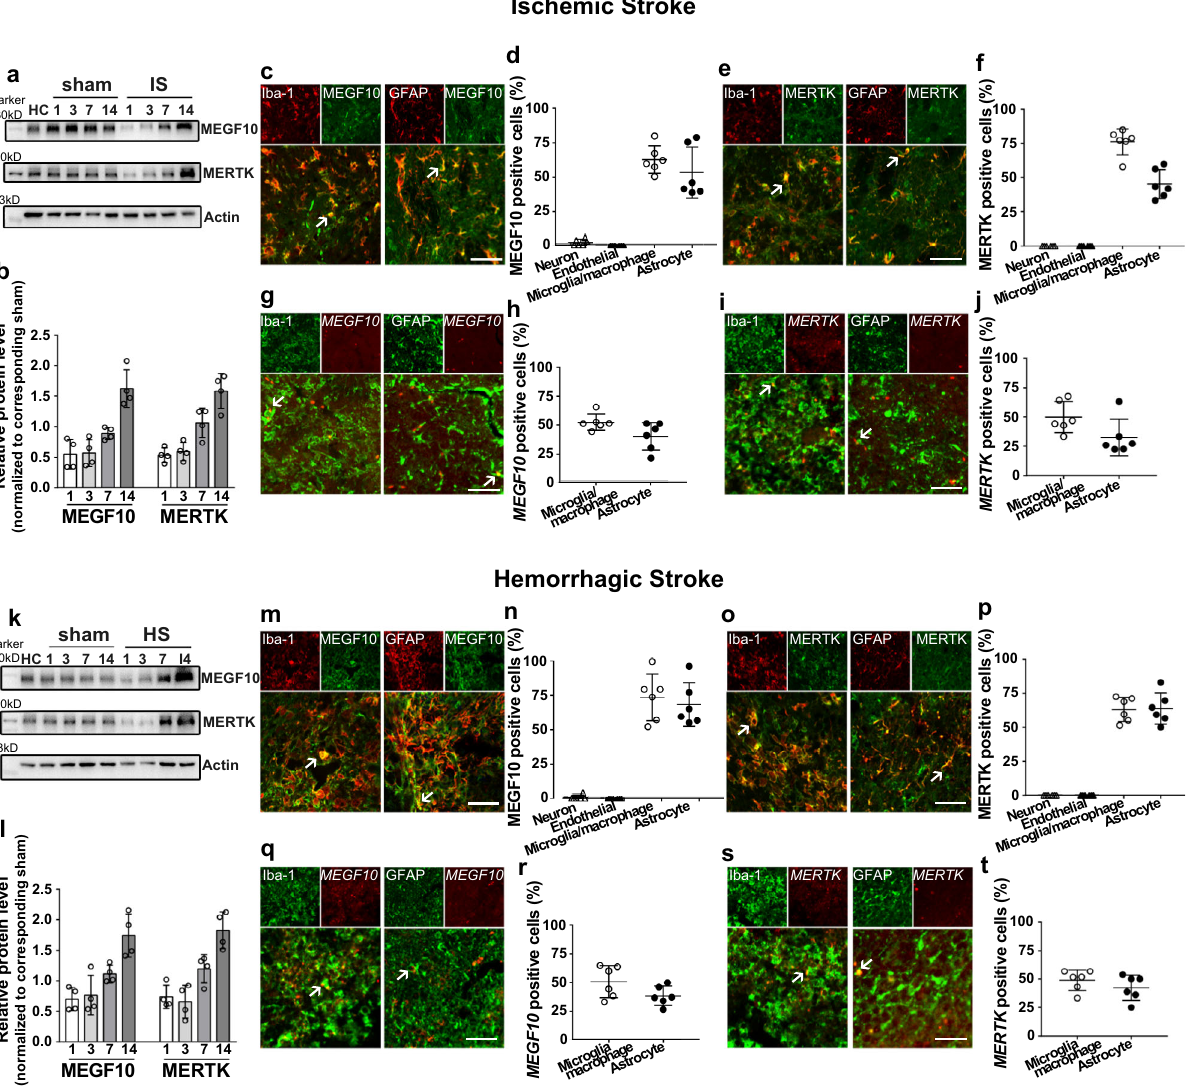
Fig. 4 Upregulation of MEGF10 and MERTK levels in mouse brain following ischemic and hemorrhagic stroke. Western blotting and quanti fi cation of MEGF10 and MERTK protein levels (normalized to corresponding sham) in ischemic ( a ) and hemorrhagic mouse brain ( k ). Immunostaining showed MEGF10 (green) and MERTK (green) were expressed in Iba-1 + microglia/macrophages (red) and GFAP + astrocytes (red) in ischemic ( c – f ) and hemorrhagic stroke ( m – p ). Arrows indicated colocalization of MEGF10 and MERTK with microglia/macrophages and astrocytes. Bar = 50 µ m. Fluorescence in situ hybridization study showed MEGF10 (red) and MERTK (red) signals colocalized in Iba-1 + microglia/macrophages (green) and GFAP + astrocytes (green) in ischemic ( g – j ) and hemorrhagic stroke ( q – t ), indicated by arrows. Bar = 50 µ m. ( b , l ) N = 4 mice per group. ( d , f , h , j , n , p , r , t ) Statistics are derived from six slices, n = 3 mice per group. Data are mean ± SD.